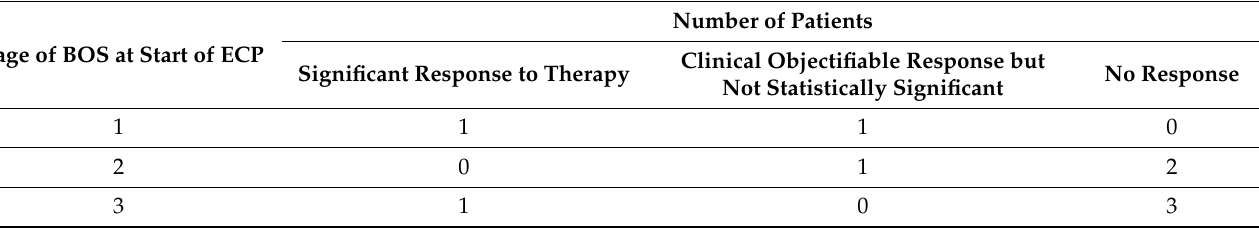
Table 4. Response pattern of BOS patients across patient